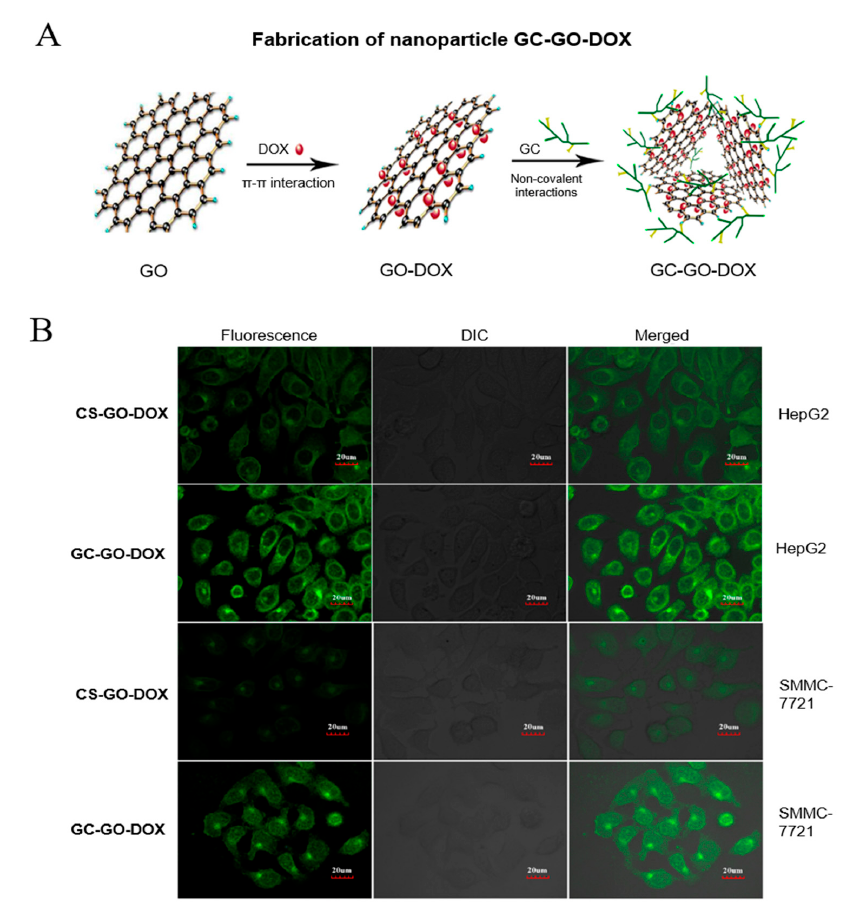
Figure 4. ( A ) Schematic illustration of the synthesis of galactosylated chitosan-modified GO-Doxorubicin (GC-GO-DOX) ( B ) localization and intracellular imaging of fluorescein isothiocyanate (FITC)-labeled GC-GO-DOX (green) and chitosan-modified GO-Doxorubicin (green) in HepG2 and SMMC-7221 cells 2 h post-transfection, scale bar 20 µm. (Reproduced with permission from [83]. Copyright 2018, Elsevier).